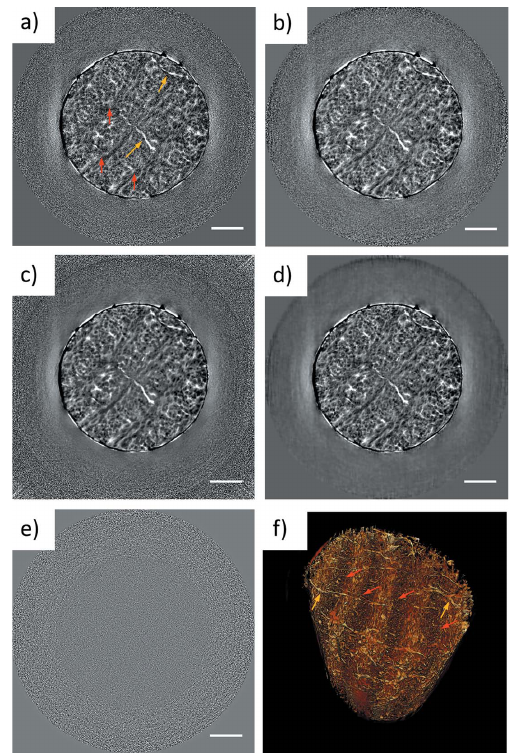
Figure 8 Denoising of a bone sample, showing ( a ) a slice of the unfiltered reconstruction, ( b ) a slice filtered with the median 3D filter and ( c ) the NLM filter. ( d ) The denoised slice performed using a network trained on a different structurally similar sample. ( e ) Difference image of the unfiltered image ( a ) and the ML denoised image ( d ). ( f ) Volume rendering of the bone, achieved by thresholding the ML-denoised tomogram. Red arrows point to the lamellae and yellow arrows indicate the positions of the canaliculi. The scale bars are 5 m